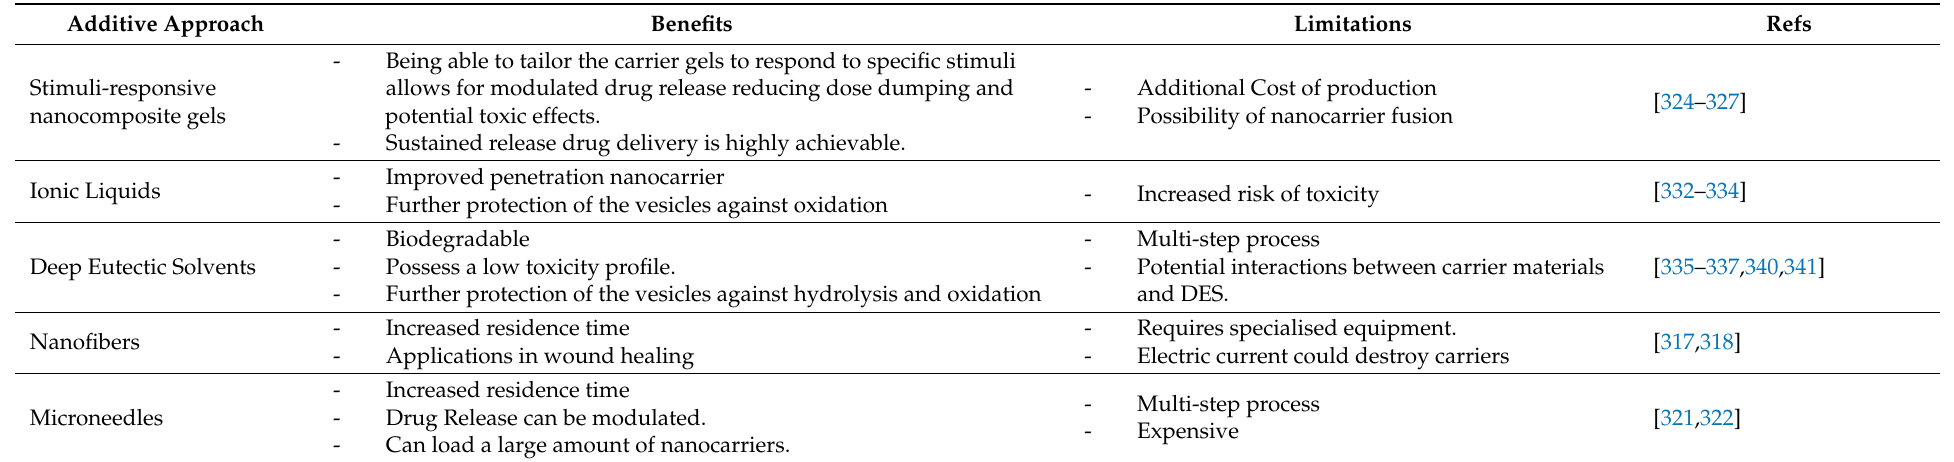
Table 3. Summary of potential additive technologies and their associated